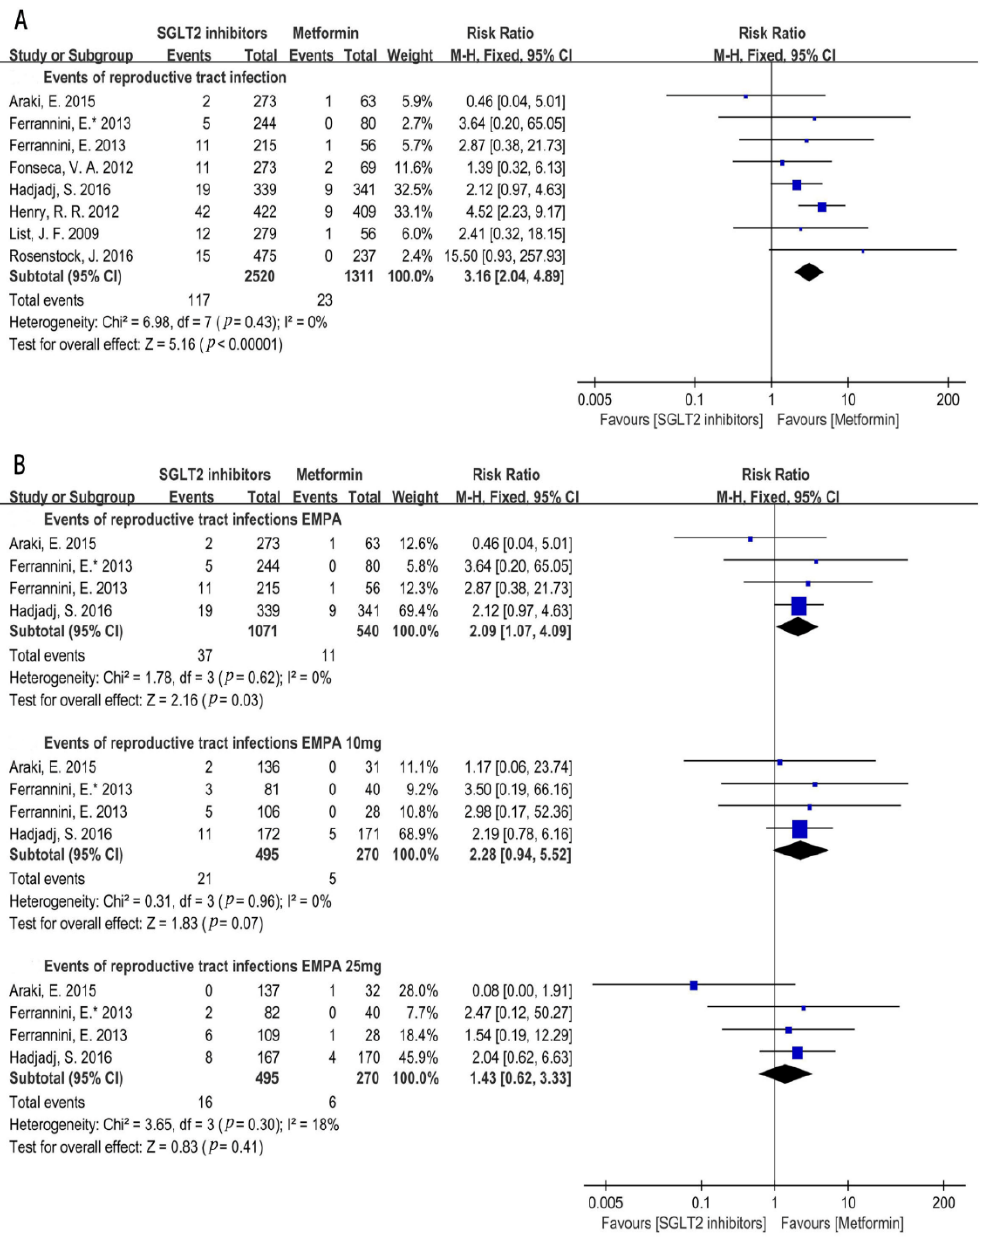
Figure 9. ( A ). Risk of reproductive tract infections in SGLT2i group compared with that of met- formin [20–25,29,31]. ( B ). Risk of reproductive tract infections with EMPA and its different doses compared with that of metformin [20–23]. EMPA = empagliflozin. As for the sex-specific subgroup of RTIs, the results found that SGLT2i led to a higher incidence of an RTI for both male and female subgroups (Male: RR = 4.53, 95% CI = 1.77 to 11.61, p = 0.002, I 2 = 13%, N = 5; Female: RR = 2.85, 95% CI = 1.68 to 4.86, p = 0.0001, I 2 = 53%, N = 4, Figure 10A), which was in accordance with the aforementioned results (Figure 9A). In addition, treatment with empagliflozin resulted in a higher risk of an RTI in male patients (empagliflozin: RR = 4.28, 95% CI = 1.17 to 15.58, p = 0.03, I 2 = 54%, N = 3) (Figure